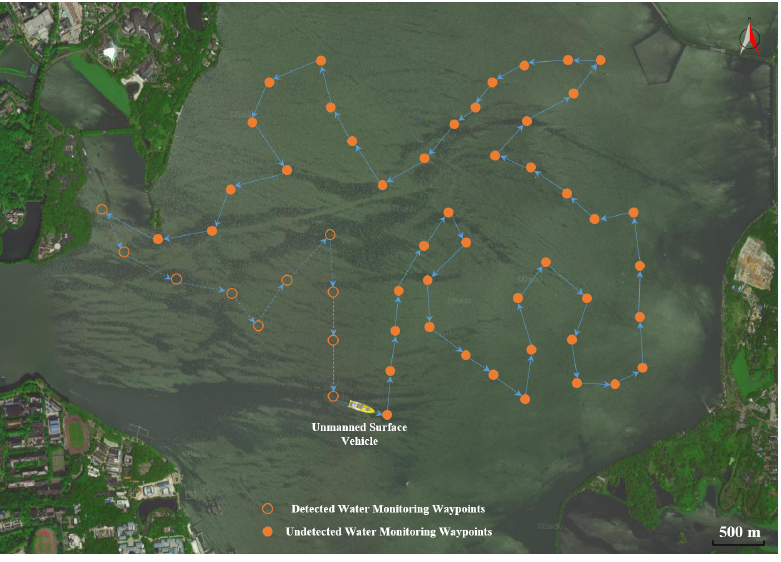
Figure 1. A USV conducting the environmental monitoring